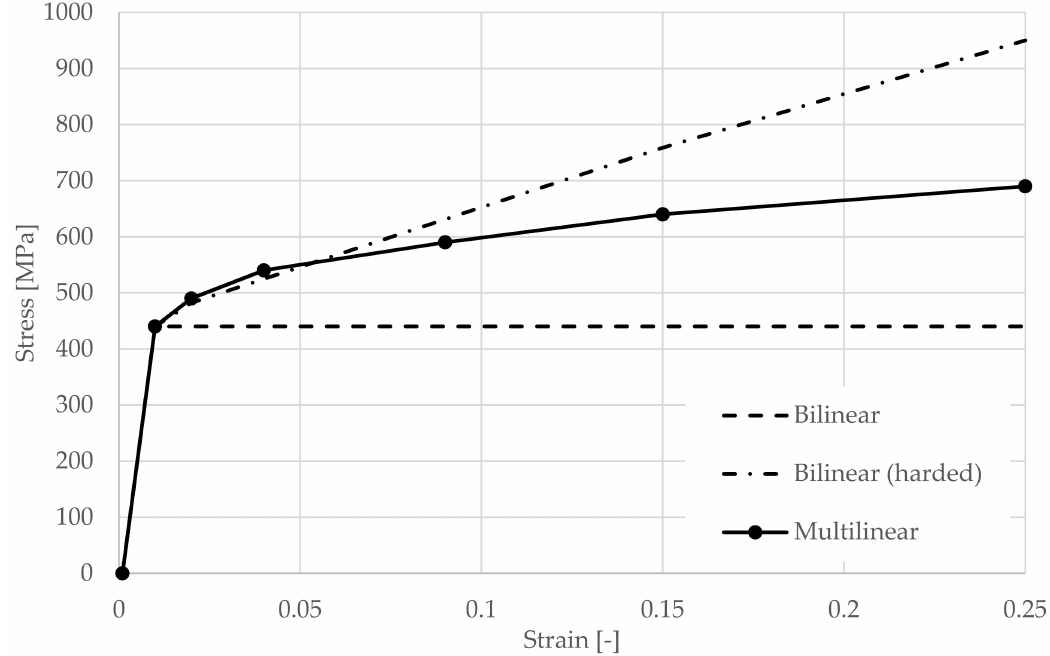
Figure 10. Stress-strain diagram